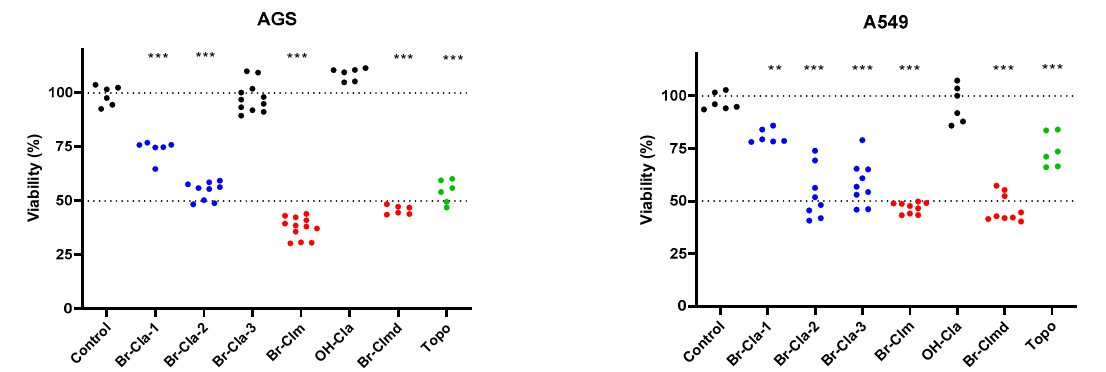
Figure 2. Impact of compounds upon the viability of AGS (left) and A549 (right) cells at 24 h. All molecules were tested at 100 µ M, and viability was assessed using the MTT method. Each dot represents an individual determination. Positive control: topotecan (10 µ M, Topo). Statistical analysis was conducted between each treatment and the control. ** p < 0.01, *** p < 0.001.